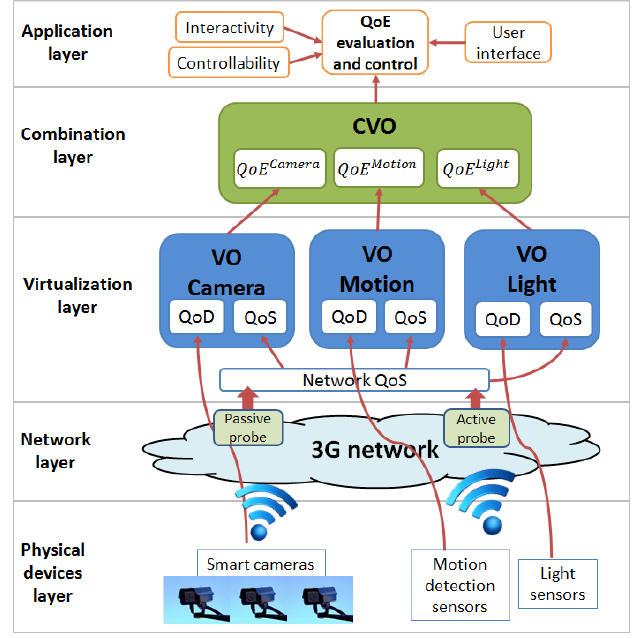
Figure 10. Framework of the smart surveillance